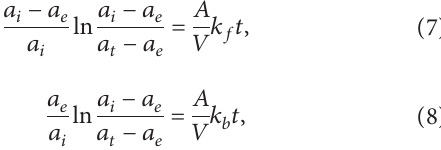
Figure 2: The process steps for preparing pure sodium chloride in